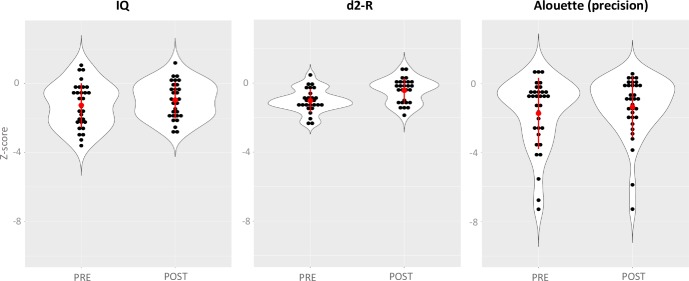
Violin plots for each test showing significant improvements from pre to post-music training.Violin plots (R Development Core Team, 2018) show the shape of the distribution. Each black dot represents one child, the red dot corresponds to the mean and the red line to the standard deviation (SD). Z-scores are indicated on the ordinate.